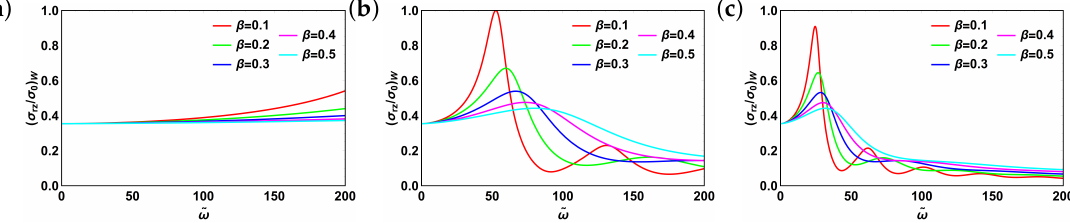
Figure 4. Shear stress profile at the pipe wall for fractional Maxwell model: ( a ) ˜ a = 0.01; ( b ) ˜ a = 0.05; ( c ) ˜ a = 0.1. For all plots α = 0.5. Subscript “w” stands for